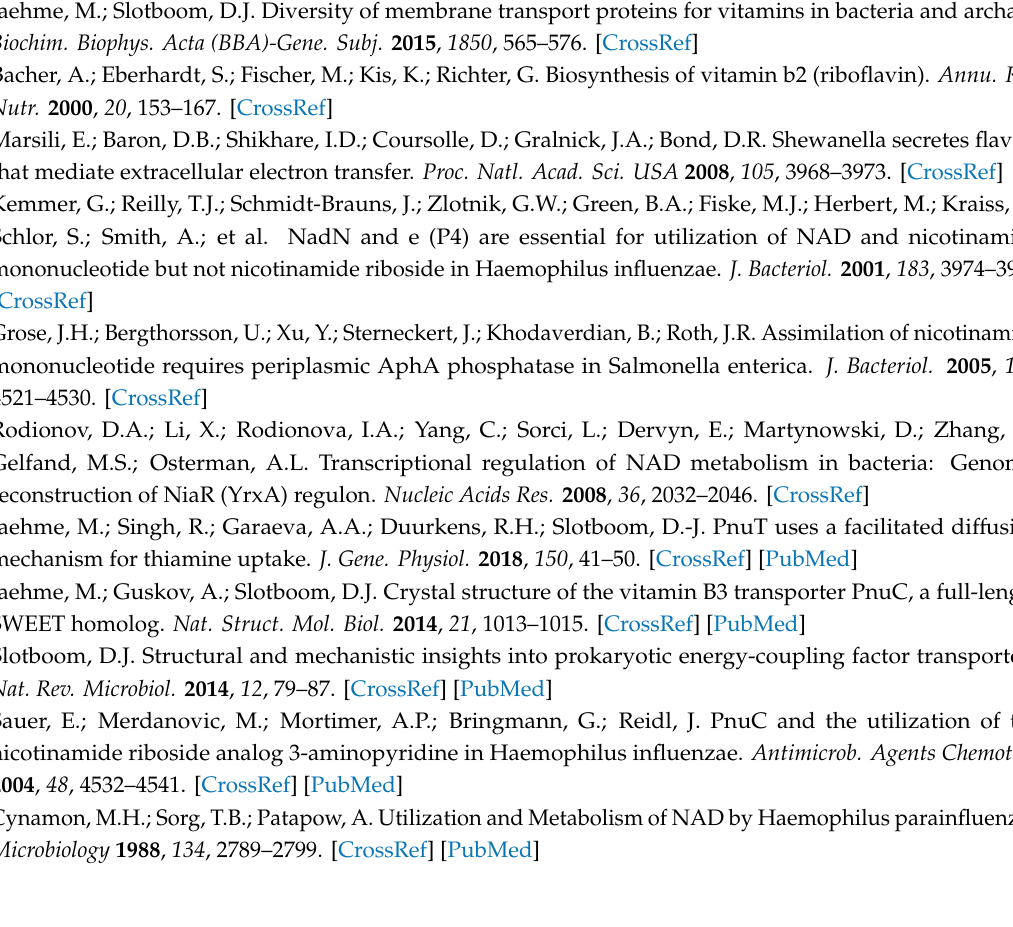
at 1.5 σ ) and ( C ) mixture of NAD and AMP-PNP (contoured at 1 σ